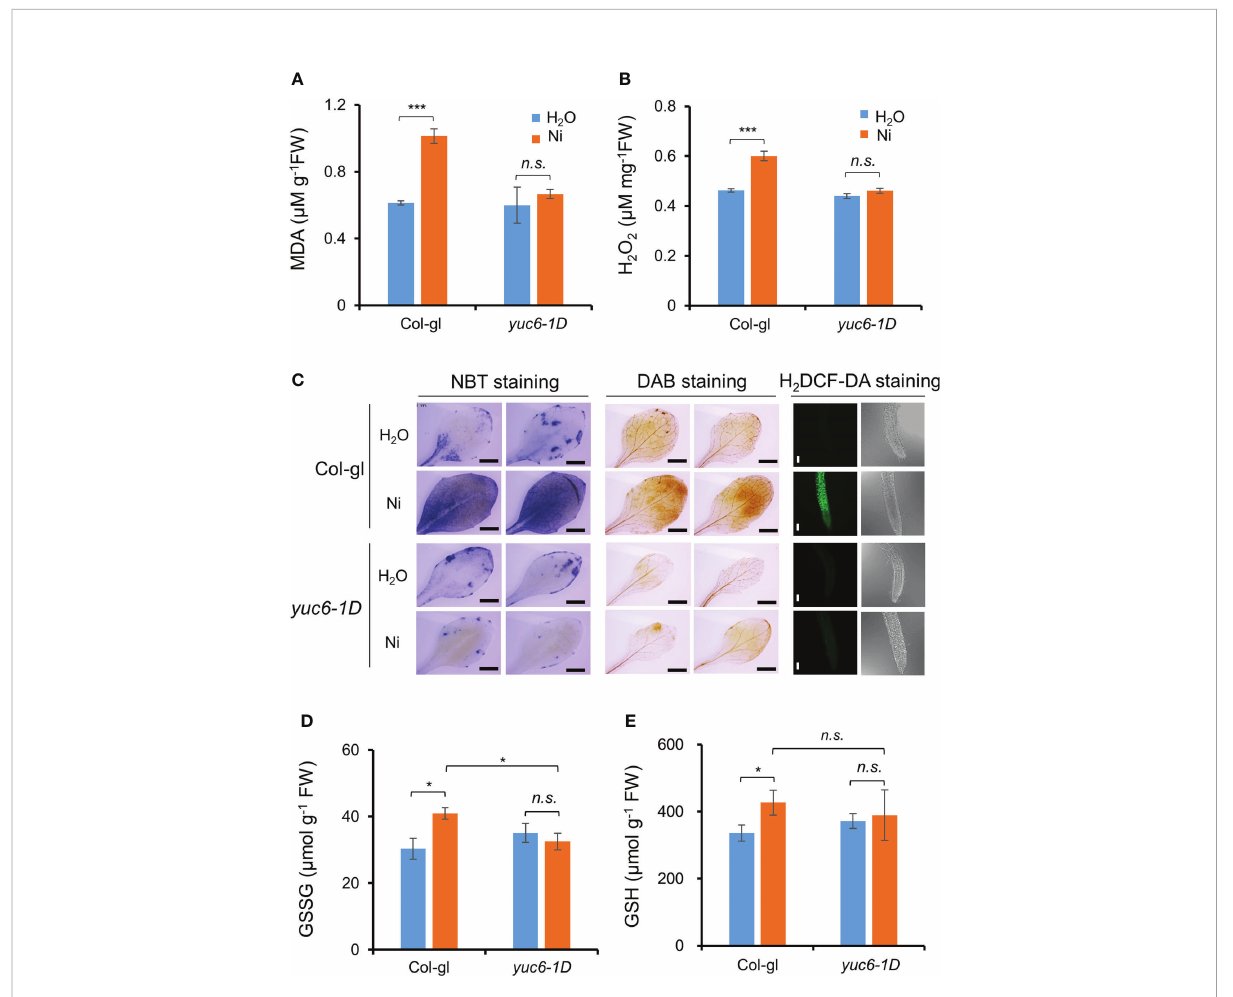
FIGURE 6 YUC6 inhibits Ni stress-induced oxidative damage via inhibition of ROS accumulation. Two-week-old Col-gl WT and yuc6-1D plants were treated with or without 100 m M Ni for 12 hrs and measured MDA (A) , H 2 O 2 (B) , GSH (D) , and GSSG contents (E) . Values are means ± SE of three (A, B) or four (D, E) independent biological replicates. Asterisks indicate signi fi cant differences (* p < 0.05, *** p < 0.001, and n.s. , no signi fi cant) from H 2 O treatments in each genotype or between Ni-treated Col-gl and yuc6-1D determined by a two-tailed Student ’ s t -test. (C) Histochemical staining for detecting Ni stress-induced ROS accumulation in plant cells. Six-day-old seedlings stained by NBT, DAB, and H 2 DCF-DA. Representative images are shown from 3 independent experiments. Scale bar = 1 mm (for NBT and DAB) or 100 µm (H 2